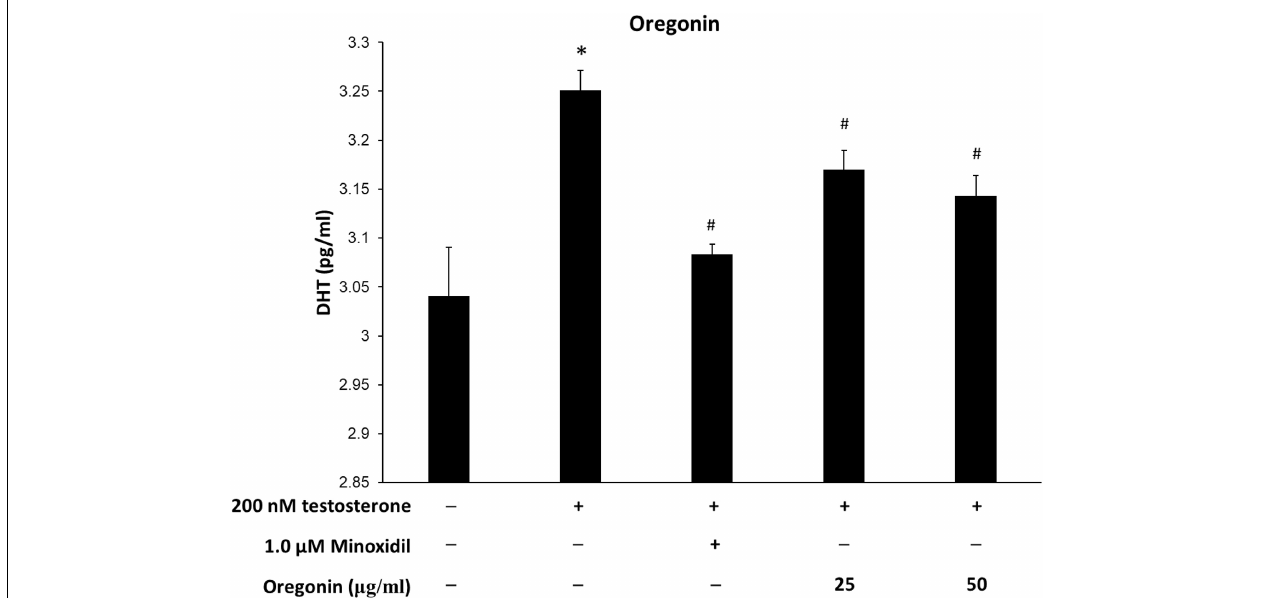
FIGURE 11 | Inhibitory effect of oregonin on dihydrotestosterone (DHT) formation. The cells were pre-incubated with the indicated dose of oregonin and treated with testosterone. The DHT content (pg/ml) in the cell lysates was measured as described in the manufacturer’s instruction. Data were expressed as mean ± SD.